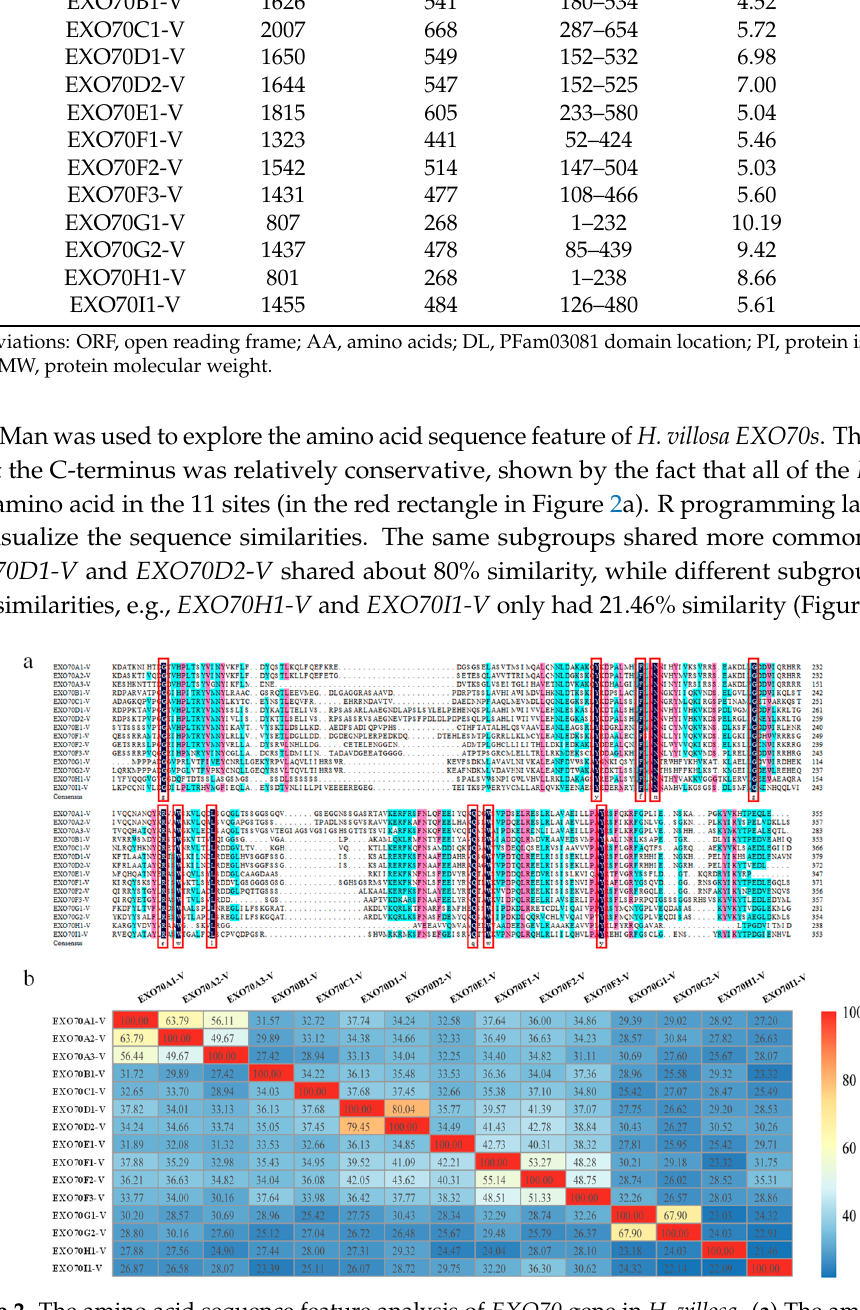
Figure 2. The amino acid sequence feature analysis of EXO70 gene in H. villosa . ( a ) The amino acid sequence of pfam03081 domain for each EXO70 was selected for multiple sequence alignment analysis by DNAMan. The 11 identical amino acids were indicated in red frame. The three colors of black, red and blue represent the level of similarity of amino acids, from high to low. ( b ) Sequence similarity analysis using the R programming language. The color scale bar represents sequence similarity between different genes. Red and yellow indicate that the sequence similarity was greater than 80% and 60%, respectively. Blue indicates that the sequence similarity was less than 40%.